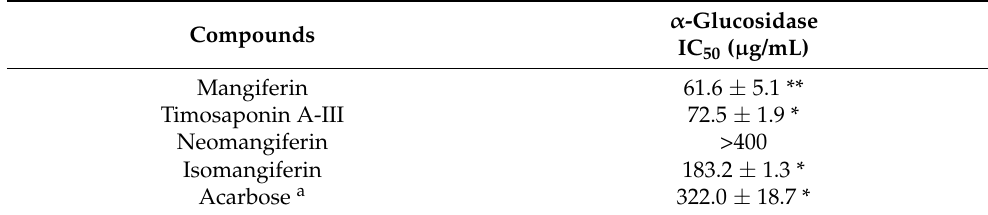
Table 7. α -Glucosidase inhibitory activities of pure compounds.